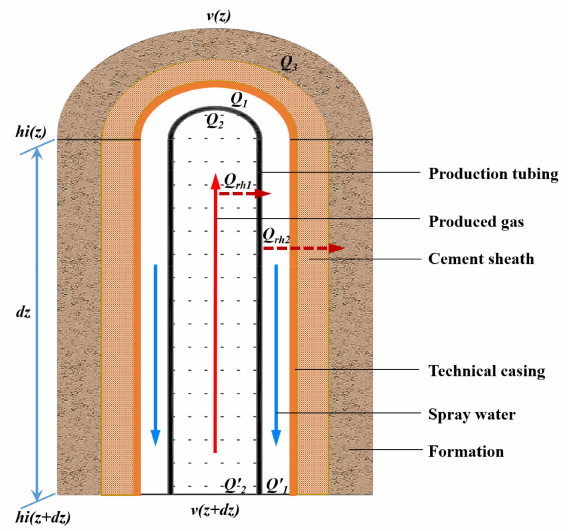
Figure 4. Temperature field calculation model of annular water injection